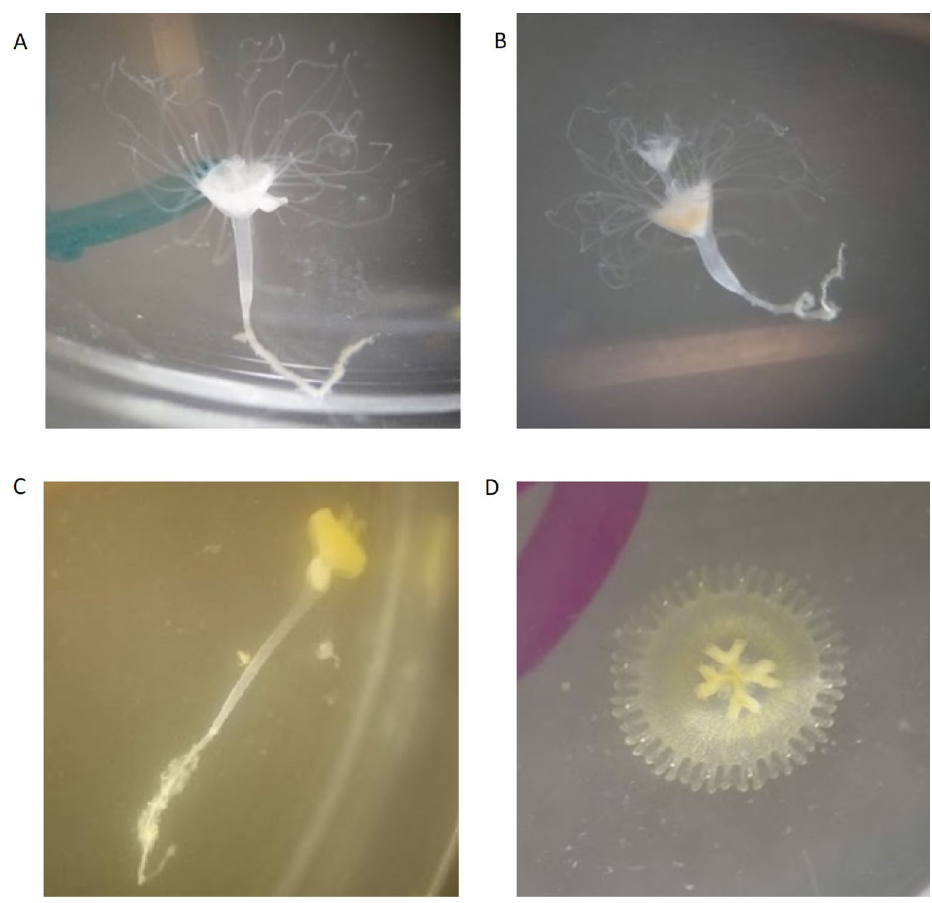
Figure 1. Cassiopea xamachana throughout development. ( A ) Budding aposymbiotic polyp, ( B ) infected polyp with brown tint of symbionts, ( C ) polyp in late stages of strobilation, and ( D ) newly detached